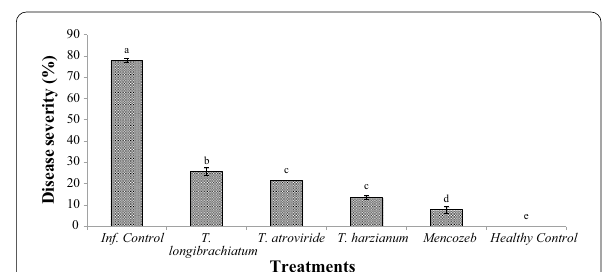
Fig. 5 Open field efficacy of Trichoderma bioagents against natural infection of Alternaria solani on tomato plants in two different seasons. Values followed by different letters indicates that means are significantly different from one another, while values followed by same letter indicate no significant difference in means according to Fisher’s least significant difference at p 0.05. Error bars on graphs = represent the Mean ±